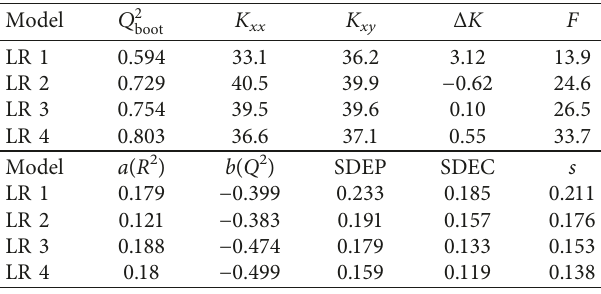
Table 4: Statistics parameters used for robustness evaluation of the MLR selected models by using MATLAB.